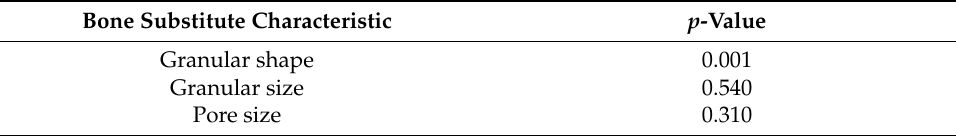
Table 2. Results of the correlation analysis using a mixed model.